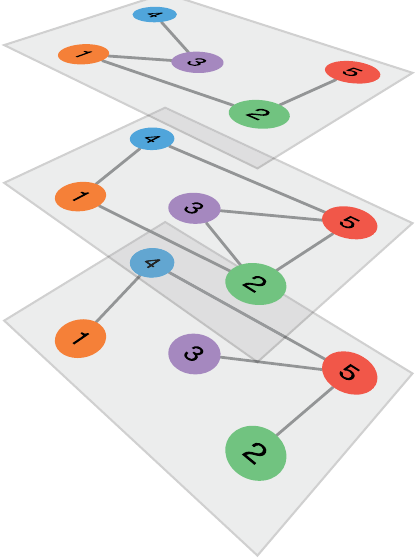
FIG. 1. A multiplex network with M ¼ 3 layers and N ¼ 5 nodes is shown. Every node i has M ¼ 3 interdependent replica nodes ð i; α Þ with α ¼ 1 , 2, 3. In this figure, triplets of replica nodes are also identified by their